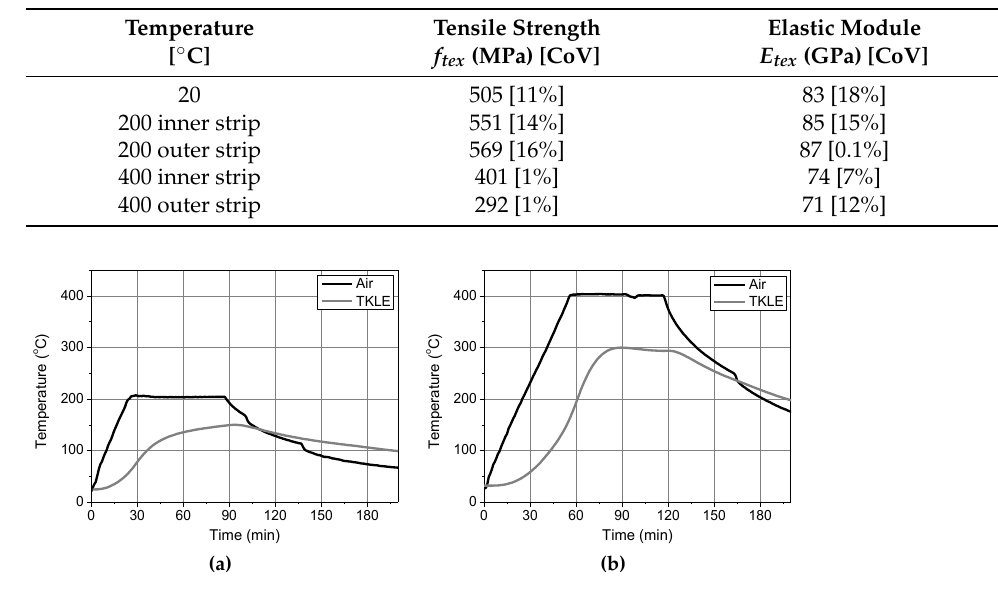
Figure 5. The temperature profiles as recorded by thermocouples during heating at ( a ) 200 °C and ( b ) 400 °C .